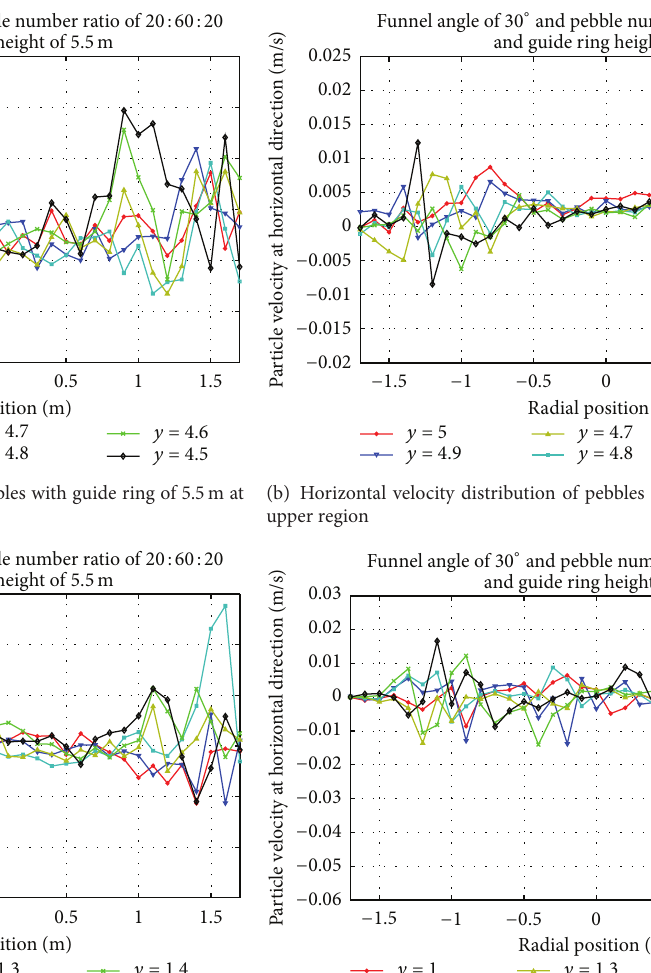
(d) Horizontal velocity distribution of pebbles with guide ring of 6m at lower region mFunnel angle of 30 ∘ and pebble number ratio of 20 : 60 : 20 and guide ring height of 6